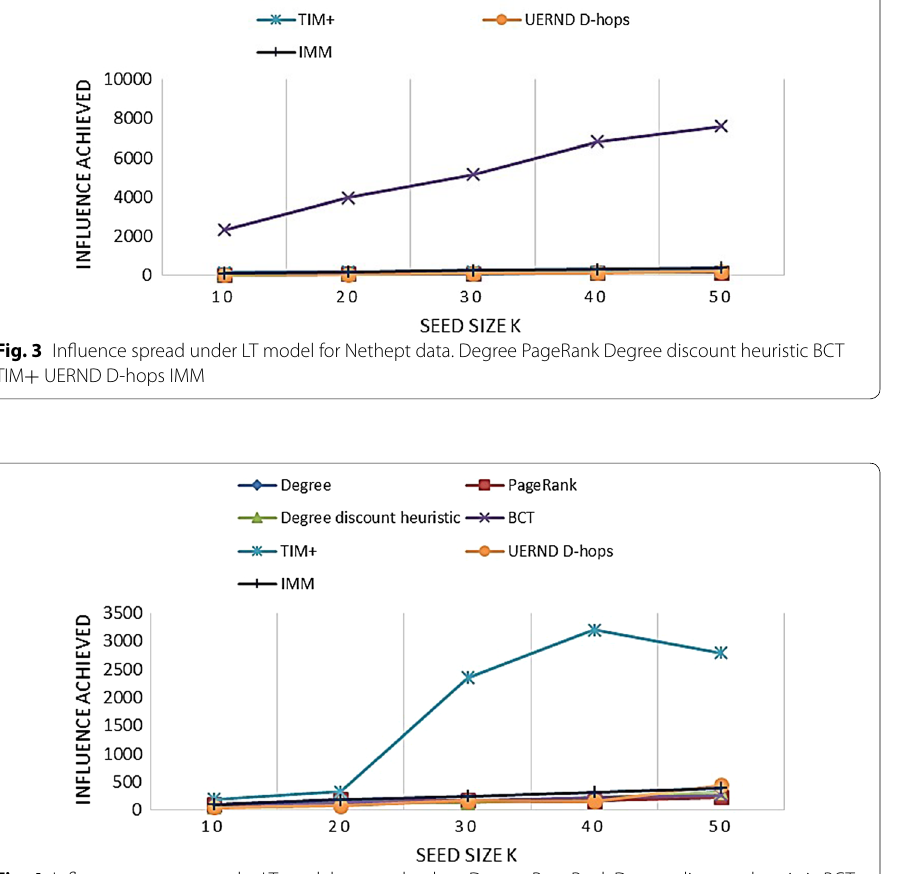
Table 2 The influence spread of our algorithm under the IC model on Netphy data